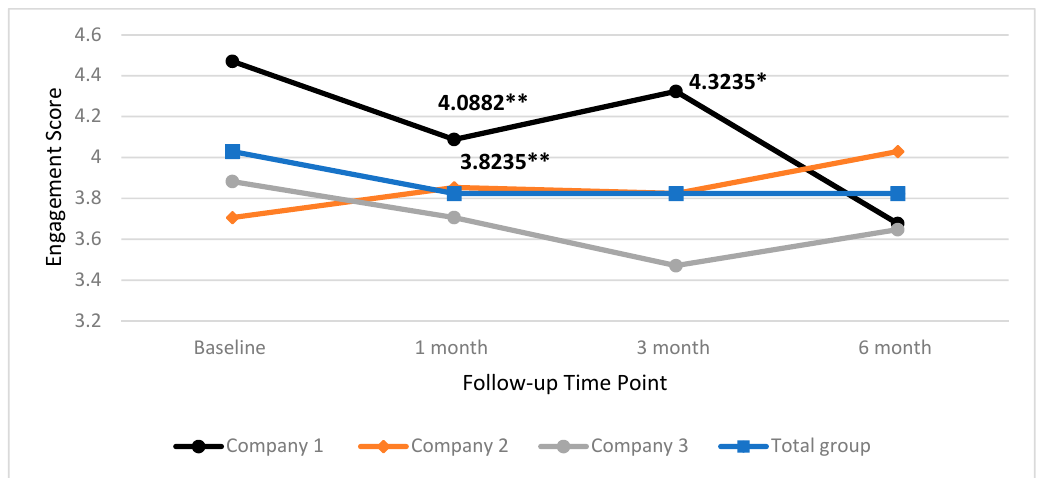
Figure 7. Median work engagement scores for total group and individual company at baseline one month, three month and six month time points. ** = significant change, * = trend towards significant